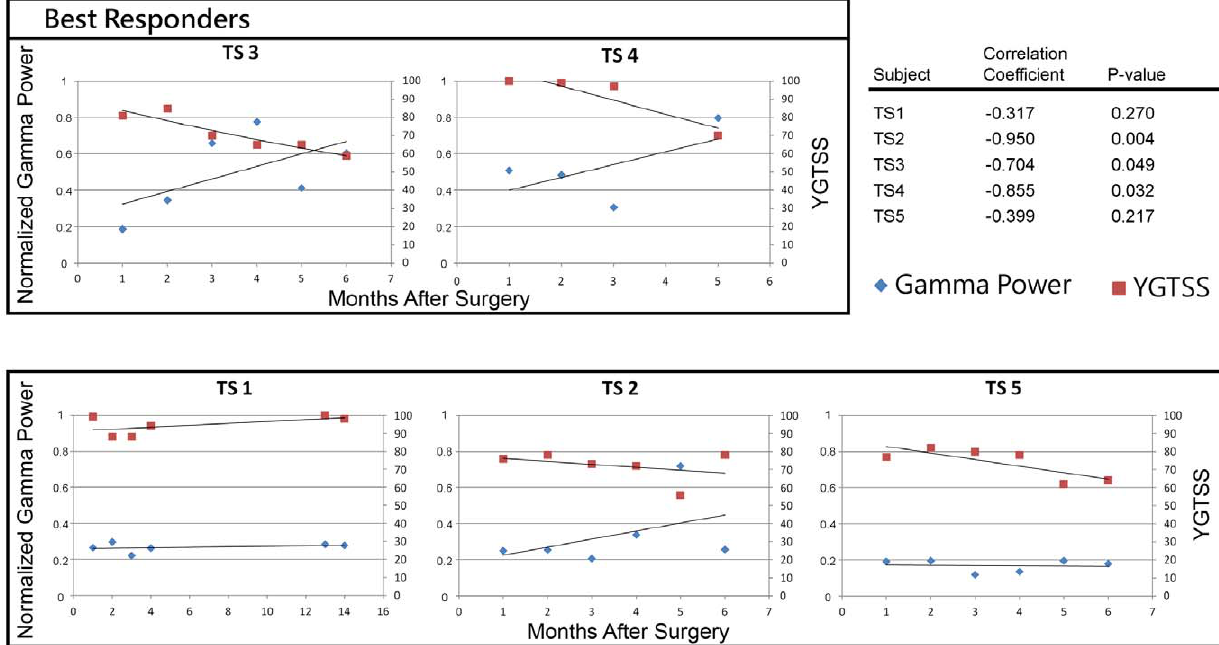
Figure 4. Relationship between increases in gamma power and clinical benefit for 5 subjects. Subjects TS2, TS3, and TS4 showed the best correlations. Box indicates TS 3 and TS 4 as best responders to therapy. Subject TS2 showed a spike in gamma power coincident with a drop in YGTSS. TS3 and TS4 showed a relatively monotonic increase in gamma power correlated with decreasing YGTSS. Subject TS 5 showed only a modest benefit from DBS therapy with correspondingly low increase in gamma power. All neural data shown is recorded from the right hemisphere.